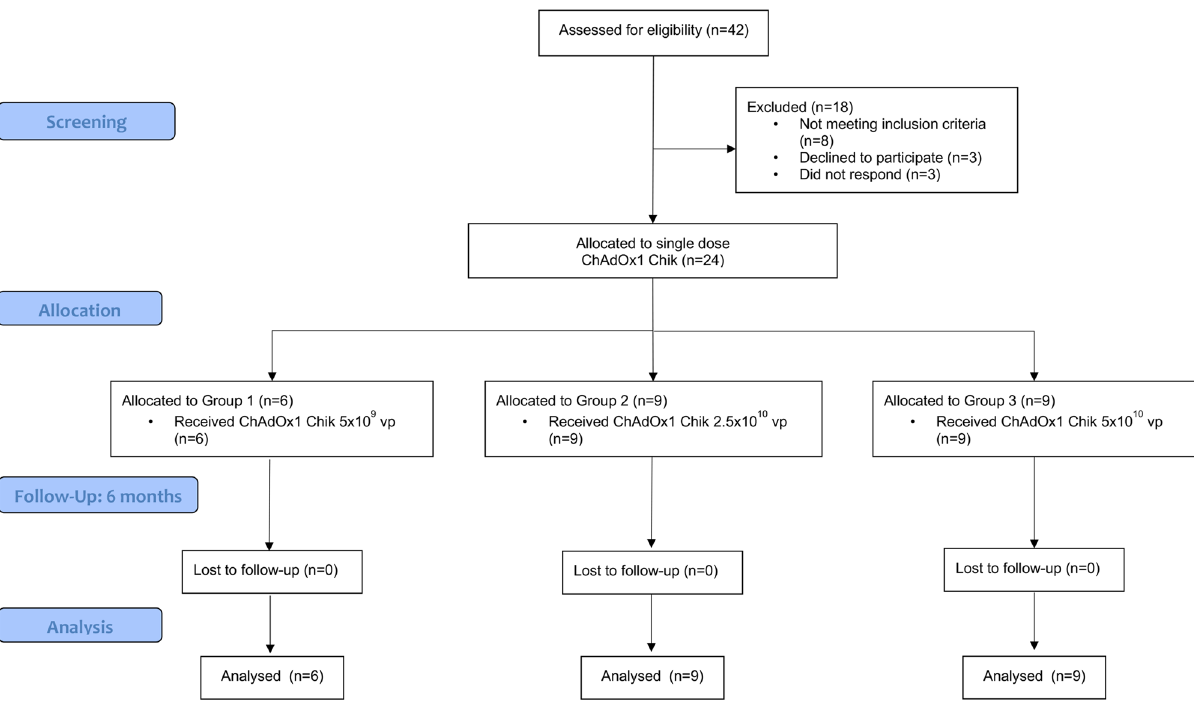
Fig. 1 Trial pro fi le. Study pro fi le showing the allocation of participants to three dosage groups: Group 1, low dose at 5 × 10 9 vp, Group 2 intermediate dose at 2.5 × 10 10 vp, and Group 3 high dose at 5 × 10 10 vp. None of the 24 recruited participants were lost in follow-up.